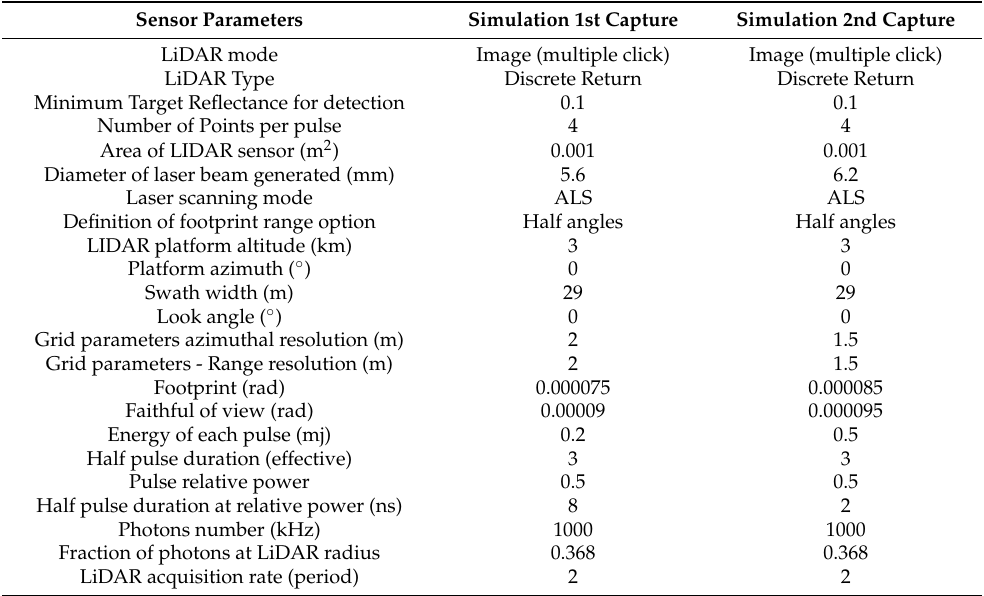
Table 4. Parameters assigned in Discrete Anisotropic Radiative Transfer (DART) to simulate each